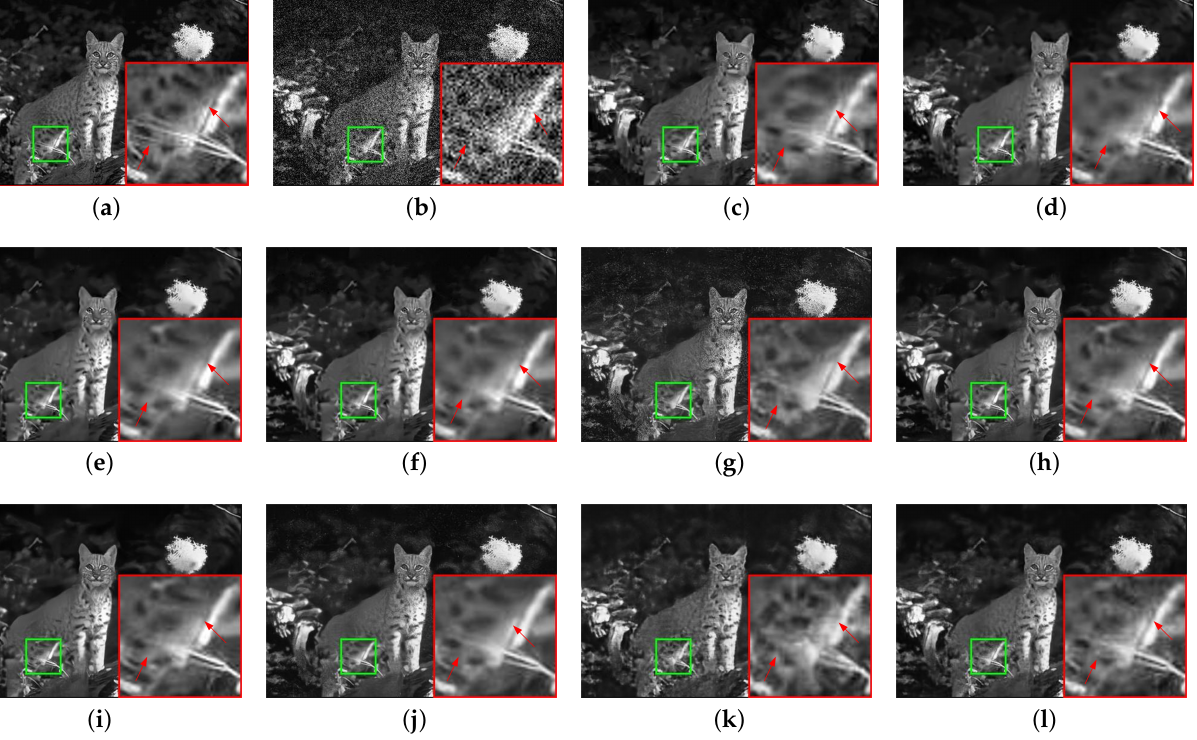
Figure 11. Denoising results of one image in BSD with noise level σ = 40: ( a ) original; ( b ) noisy image; ( c ) BM3D/26.11 dB; ( d ) NCSR/26.28 dB; ( e ) TWSC/26.46 dB; ( f ) WNNM/26.53 dB; ( g ) RED-Net/23.89 dB; ( h ) DnCNN/26.64 dB; ( i ) FFD- Net/26.69 dB; ( j ) CsNet/27.64 dB; ( k ) DIP/24.89 dB; ( l ) Proposed/28.08